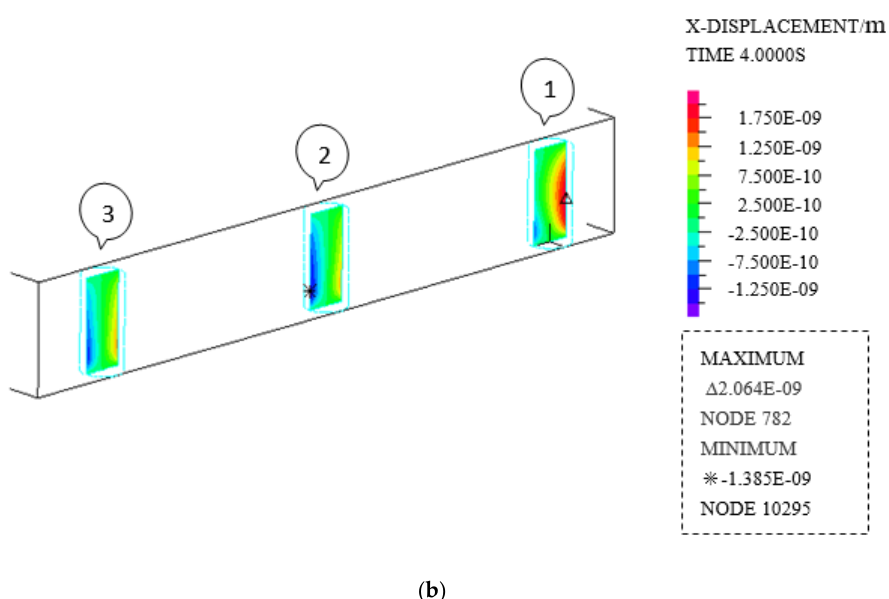
Figure 18. X-direction displacement slitting line nephogram ( a ) Rock sample models of laminar flow; ( b ) Rock sample models of Turbulence.